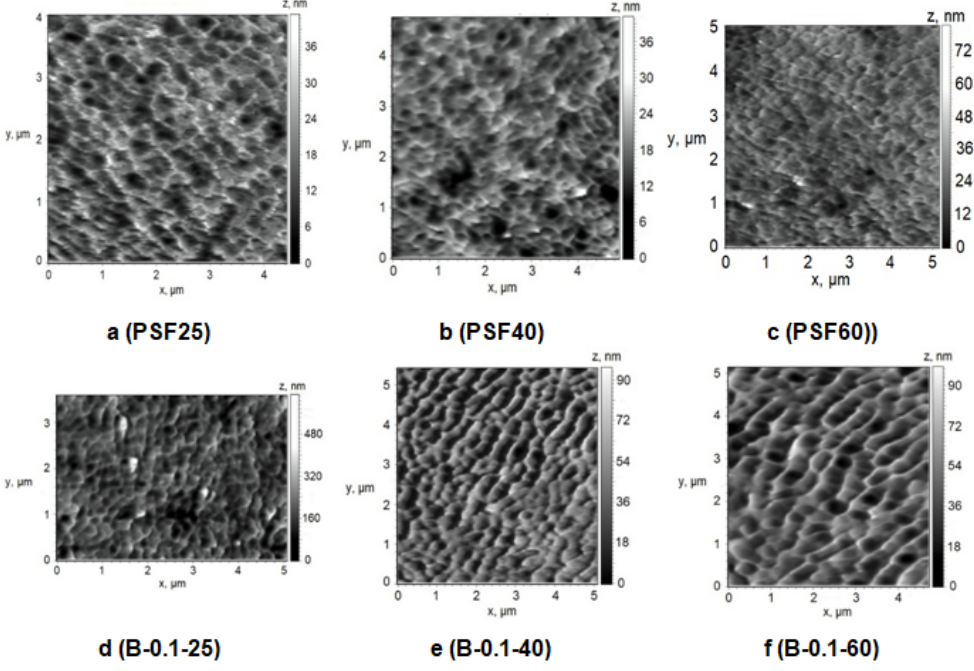
Figure 10. AFM images of the surface of the selective layer of membranes prepared at coagulation bath temperature T = 25 °C ( a , d ), T = 40 °C ( b , e ), T = 60 °C ( c , f ) and Praestol 859 concentration in the coagulation bath: ( a – c ) 0 wt.%.; ( d – f ) 0.1